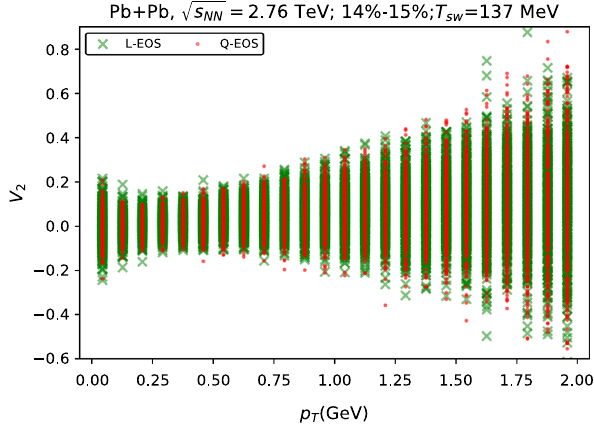
Fig. 8 Event-by-event normalized p T spectra d N / N d y d p T (left panel) and elliptic flow v 2 as a function of p T (right panel) of the train- ing datasets in Table 1 with two EoSs. The green cross and the red point